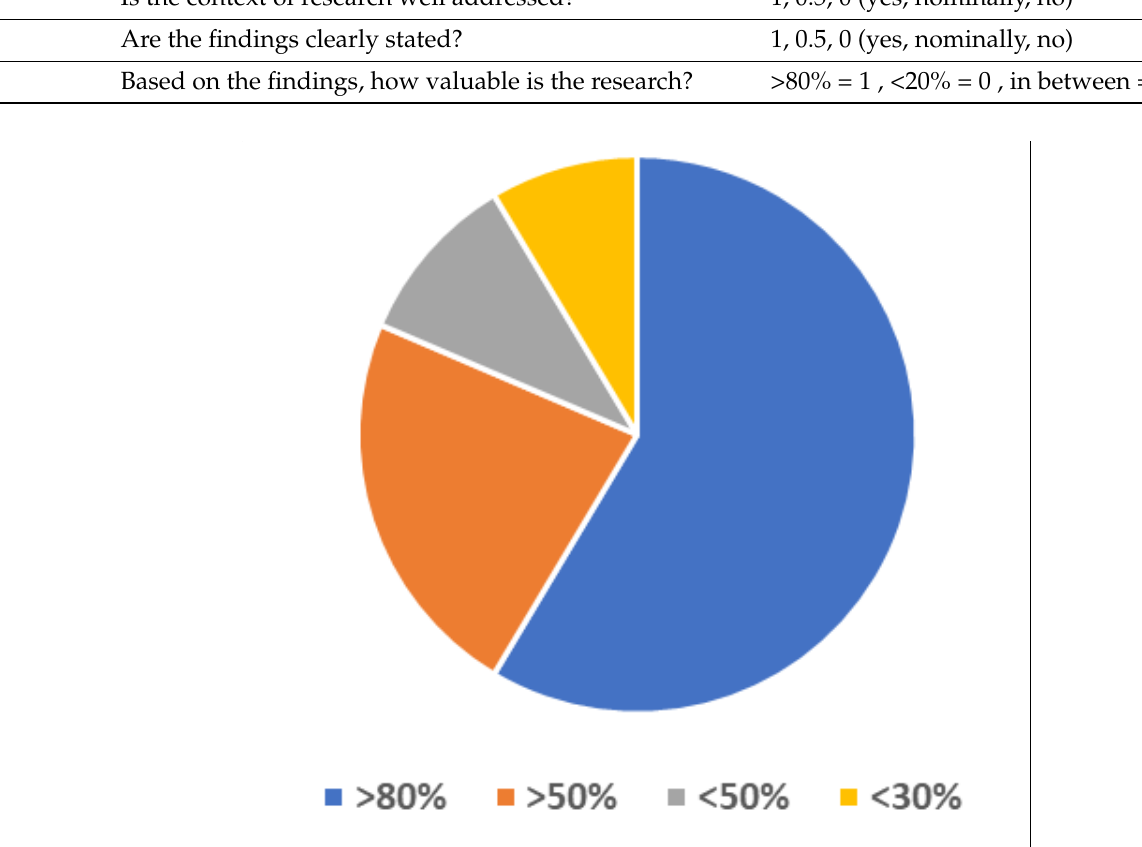
Figure 7. Graded percentage of selected